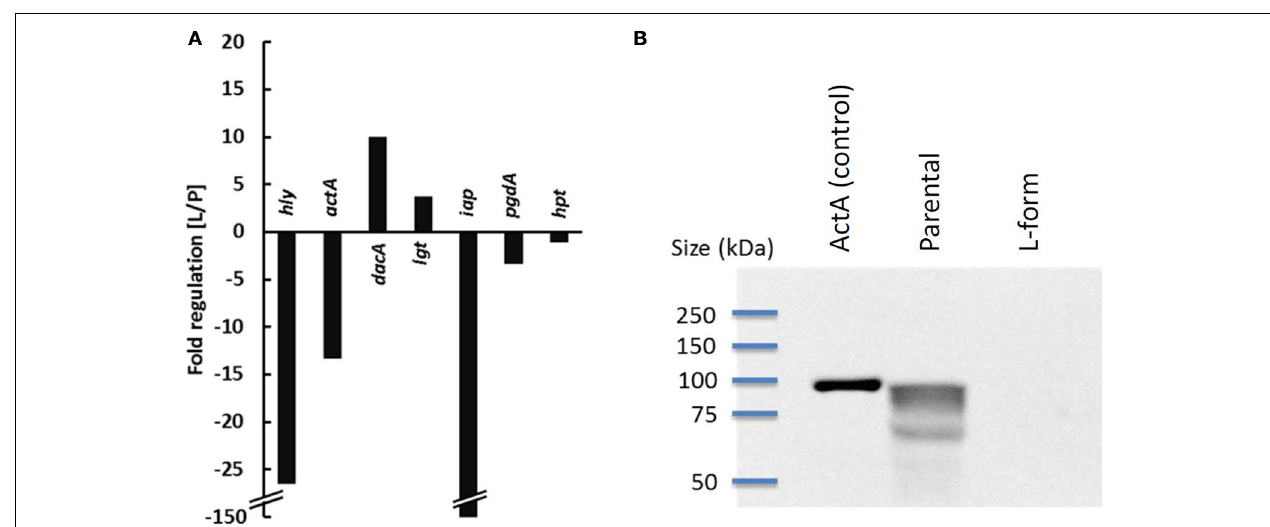
FIGURE 1 | Expression of virulence genes of parental (P) and L-form (L) L. monocytogenes ScottA-GFP 3h post infection of P-388D1 macrophages determined by Real-Time qRT-PCR. The expression of hly,